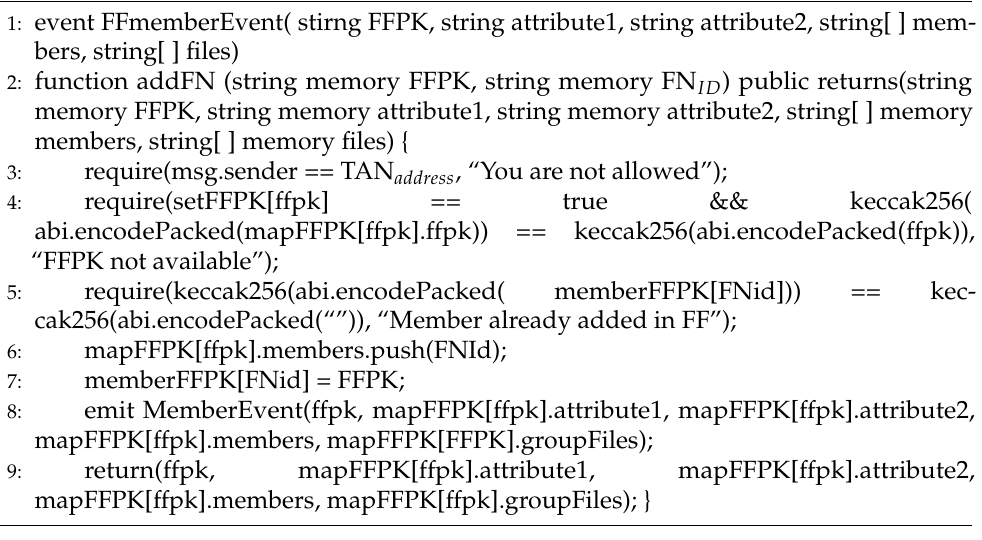
Algorithm 7 Adding FN to the FF smart contract.